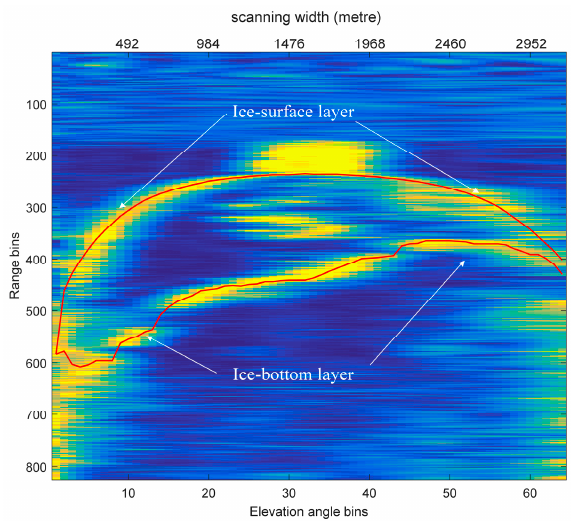
Figure 3. Illustration of a topology slice with two kinds of labels, ice-surface layer and ice-bottom layer. White arrows indicate the ice-surface layer and ice-bottom layer. The red lines are the locations of ice-surface layer and ice-bottom layer (ground truth) marked by human expert.